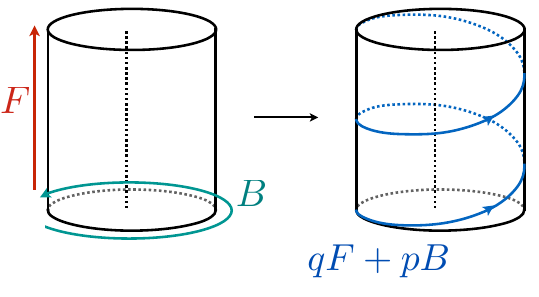
Figure 6 . Description of a singular fiber of a Seifert fibration. Instead of filling in B , one fills in qF + pB